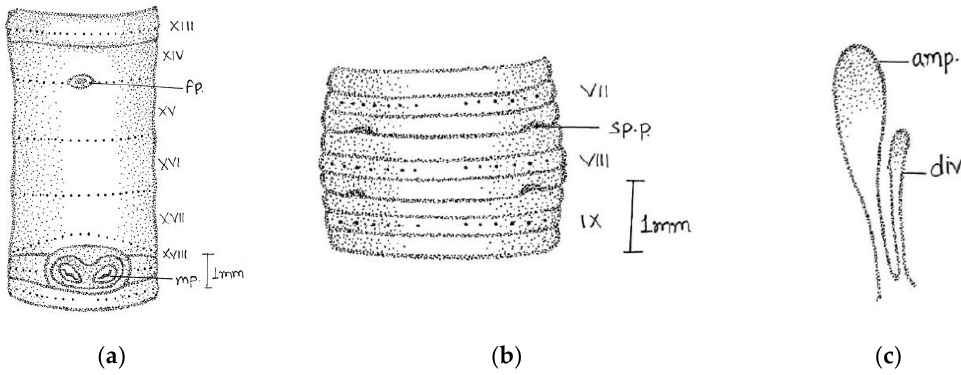
Figure 5. Camera lucida illustration of Megascolex konkanensis konkanensis ( a ) genital region; ( b ) sper- mathecal pores; ( c ) spermathecae.